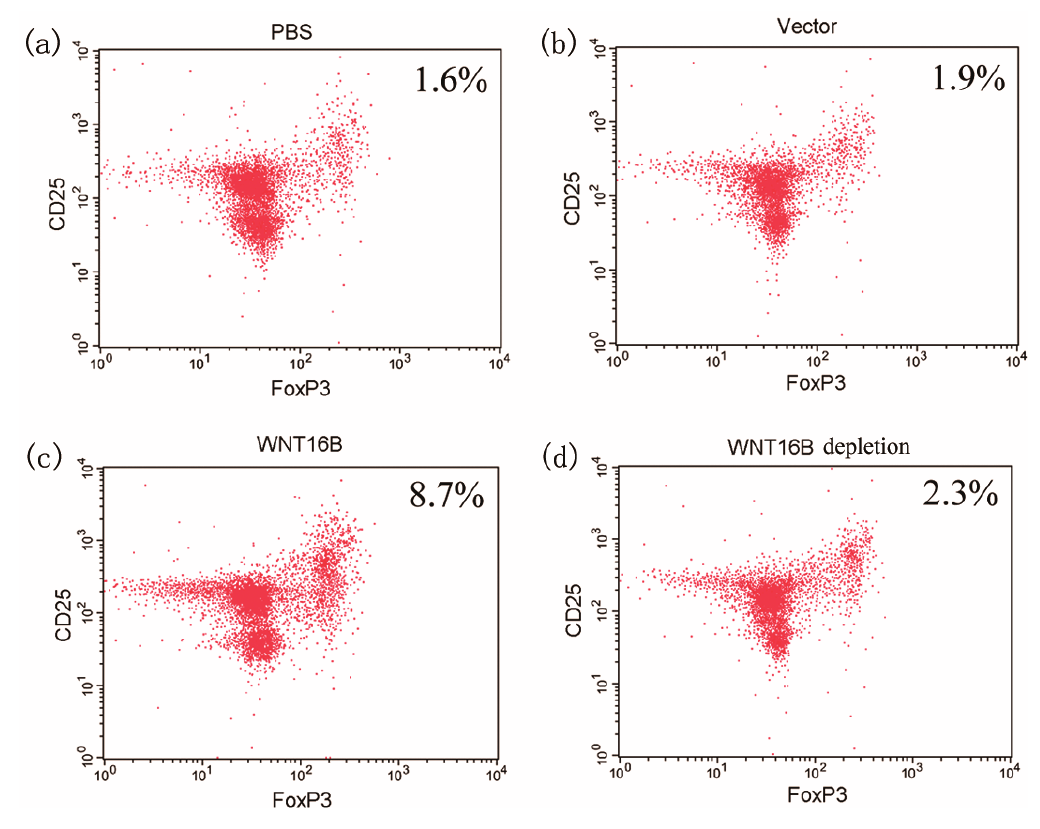
Figure 4. WNT16B induced Tregs differentiation through DCs. After co-culture of PBMCs and DCs, flow cytometry was used to assess the percentage of CD4+CD25+Foxp3+ T cells. Compared with PBS ( a ) and vector-conditioned medium ( b ); the percentage of Tregs under WNT16B-conditioned co-culture was significantly increased ( c ); However, when WNT16B-depleted medium was used, the percentage of Tregs significantly recovered ( d